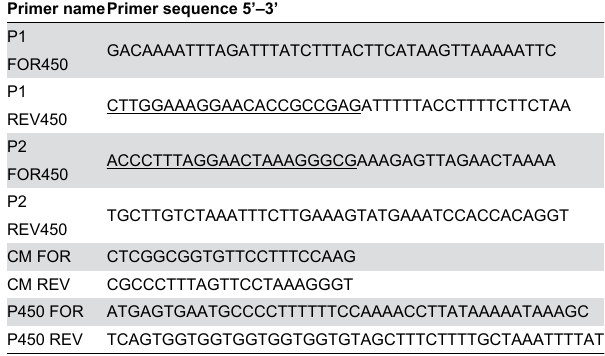
Table 1. Primers